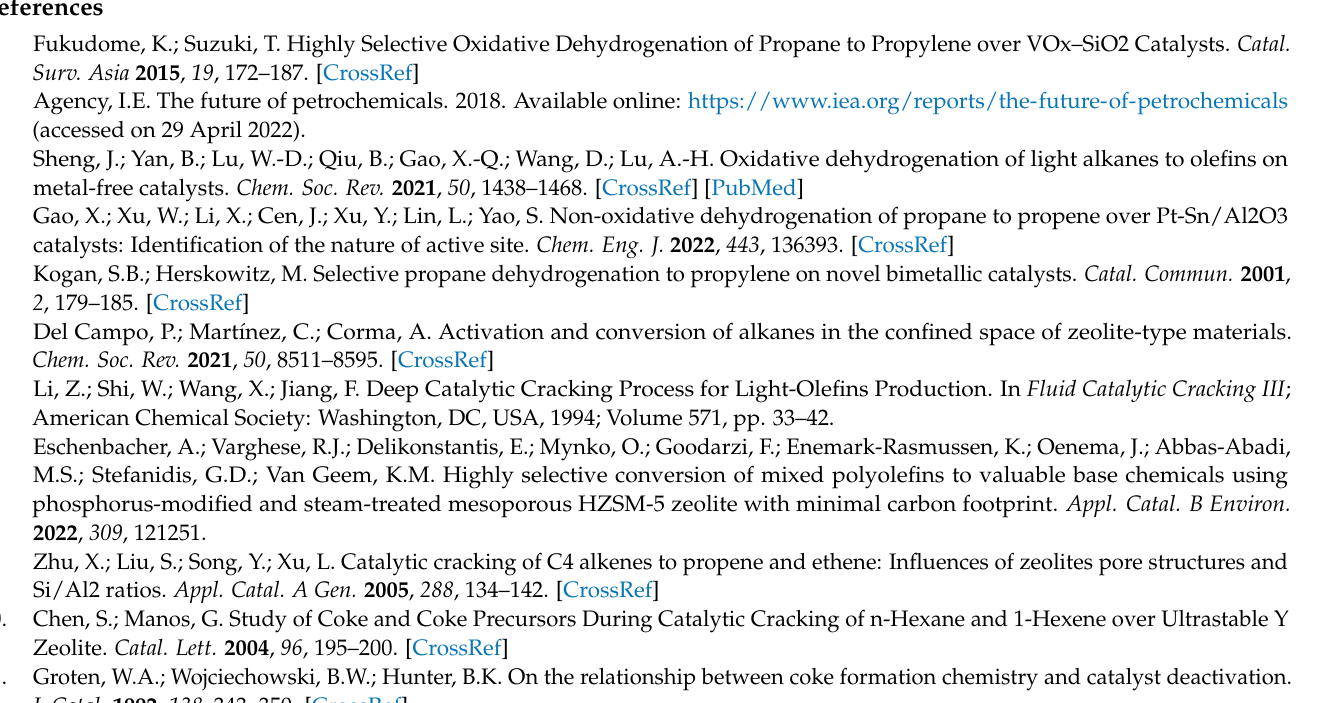
Figure S6: The ammonium hexafluorosilicate modified zeolites linearly fitting curve of pyridine cov- erage in Brønsted; Figure S7: The ammonium hexafluorosilicate modified zeolites hydroxyl groups characterization during the coke formation reaction; Figure S8: Coke formation rate of ammonium hexafluorosilicate modified zeolites; Figure S9. (a) The fitting curve and linear equation of SSY-1. (b) The fitting curve and linear equation of SSY-2. (c) The fitting curve and linear equation of SSY-3. (d) The fitting curve and linear equation of SSY-4.; Figure S10. (a) The fitting curve and linear equation of SSY-1. (b) The fitting curve and linear equation of SSY-2. (c) The fitting curve and linear equation of SSY-3. (d) The fitting curve and linear equation of SSY-4.; Table S1: Textural properties of the modified and parent zeolites; Table S2: The structural properties of the modified and parent zeolites; Table S3: Acidic properties of ammonium hexafluorosilicate modified zeolites; Table S4: The ammo- nium hexafluorosilicate modified zeolites Ed value obtained from the slope of the best-fitting curve; Table S5. The R-squared value calculation of ammonium hexafluorosilicate modified zeolites with pyridine desorption reaction order 1, 2 and 3 respectively. A calculation method of the desorption rate of pyridine.; A calculation method of extra-framework Al concentration of per unit cell. A calculation method of B acid sites concentration